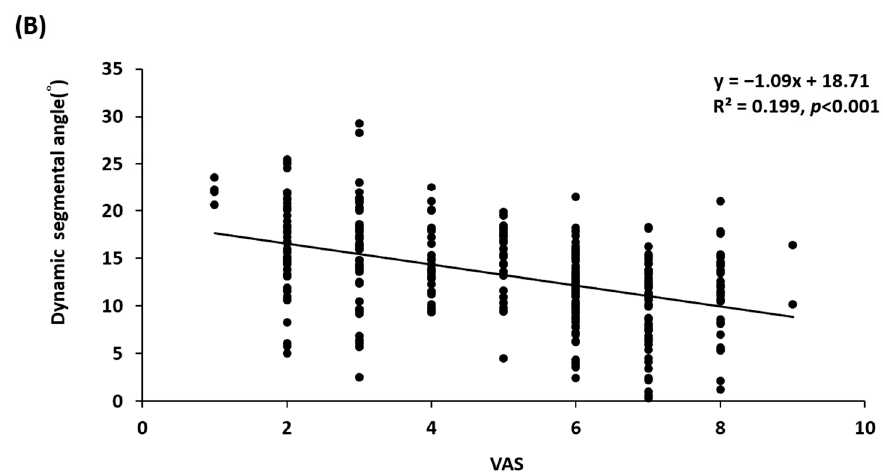
Figure 4. Relationships between VAS score (including all scores of baseline and final VAS) and corresponding dynamic slip ( A ), and dynamic segmental angle ( B ). The blot picture showed that both dynamic slip and dynamic segmental angle versus pain scores presented an inverse relationship.